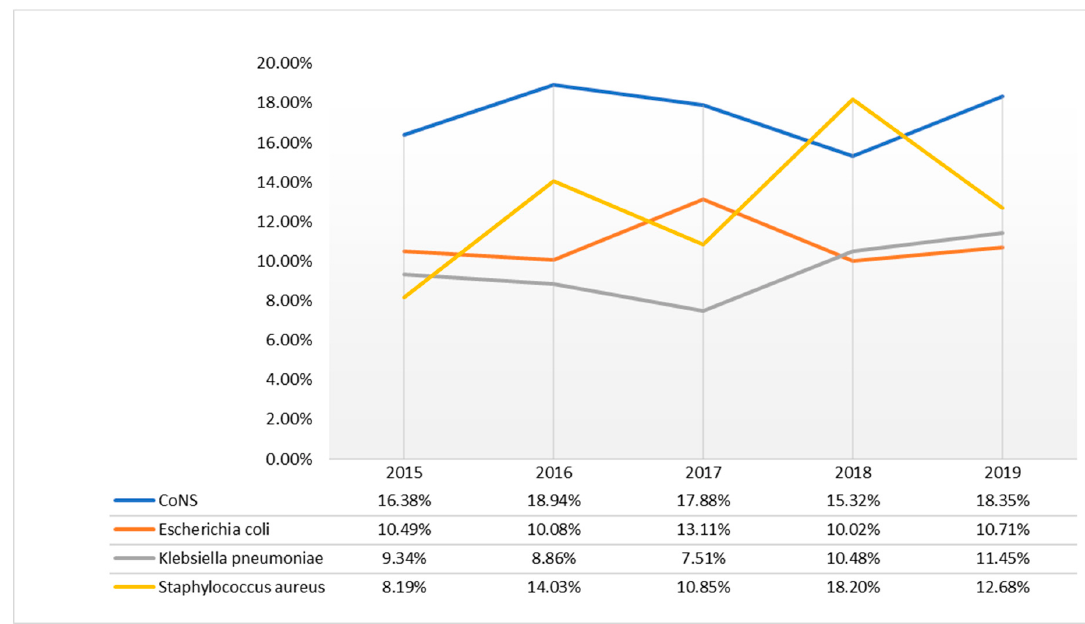
Figure 4. Trend in percentage of batteries caused by the most frequent isolates.